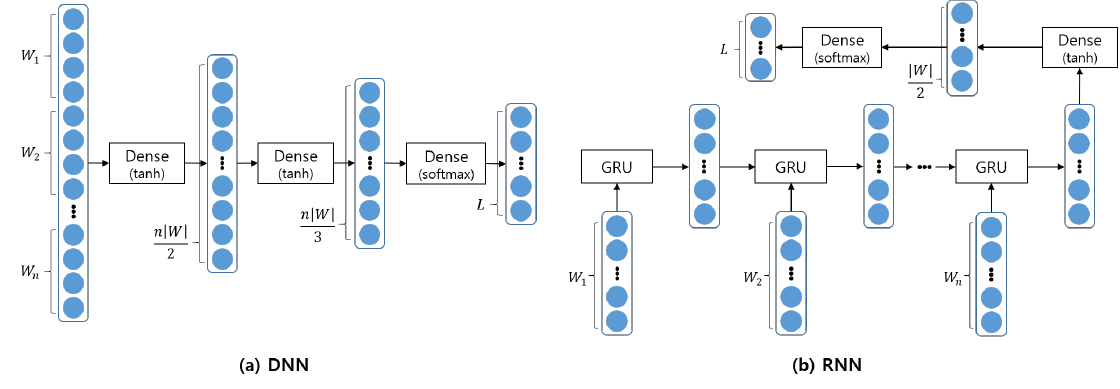
Figure 2. The proposed structures of ( a ) DNN and ( b ) RNN.